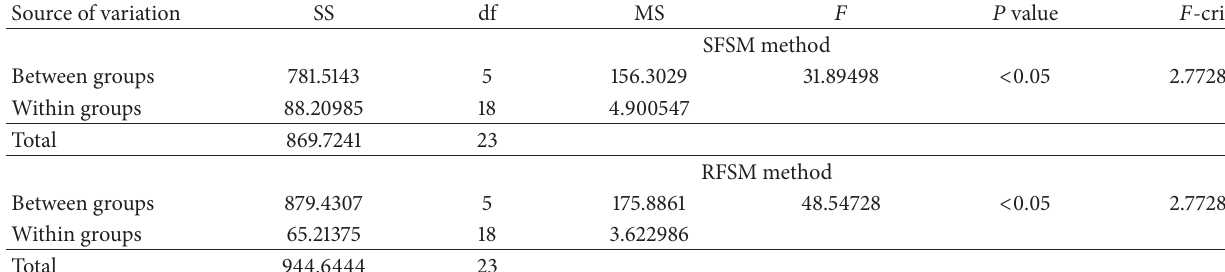
Table 11: ANOVA results for accuracy rate of classifiers.